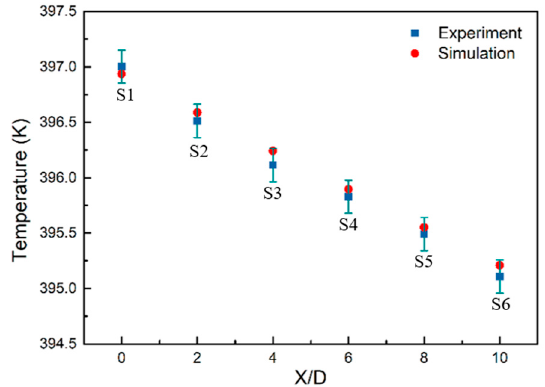
Figure 7. Average temperatures in streamwise direction of straight pipe.